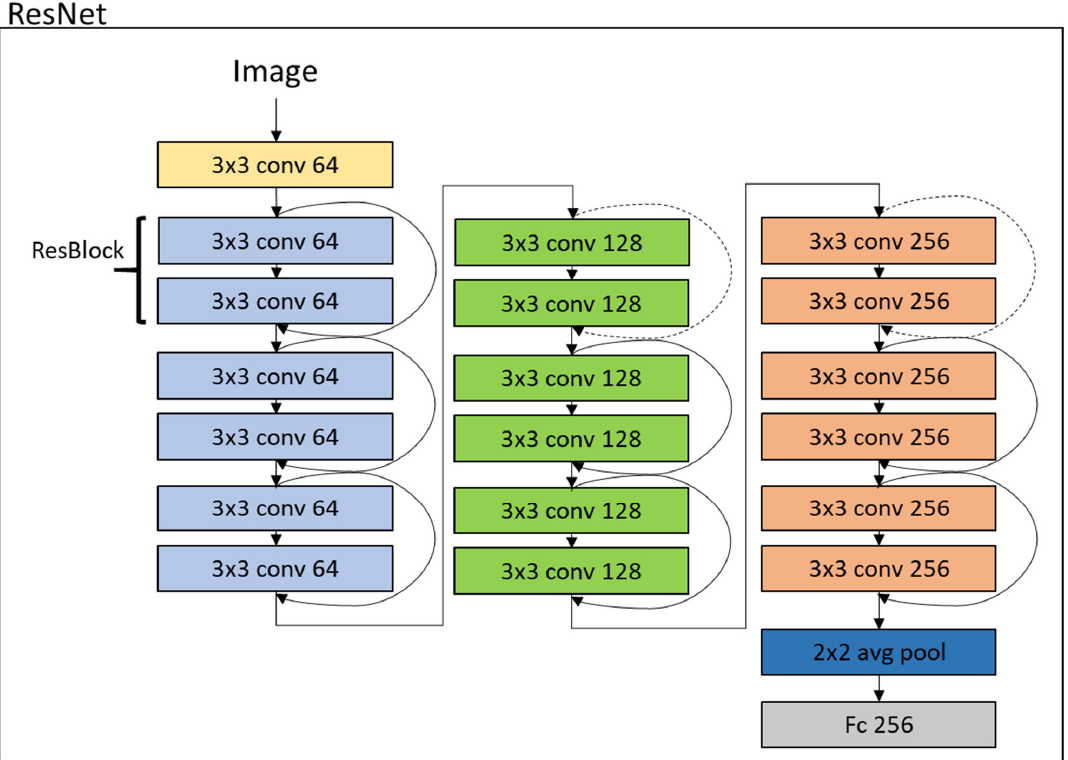
Figure 3 . Architecture of the ResNet convolutional network. Curved arrows represent shortcut connections, as in He et al.